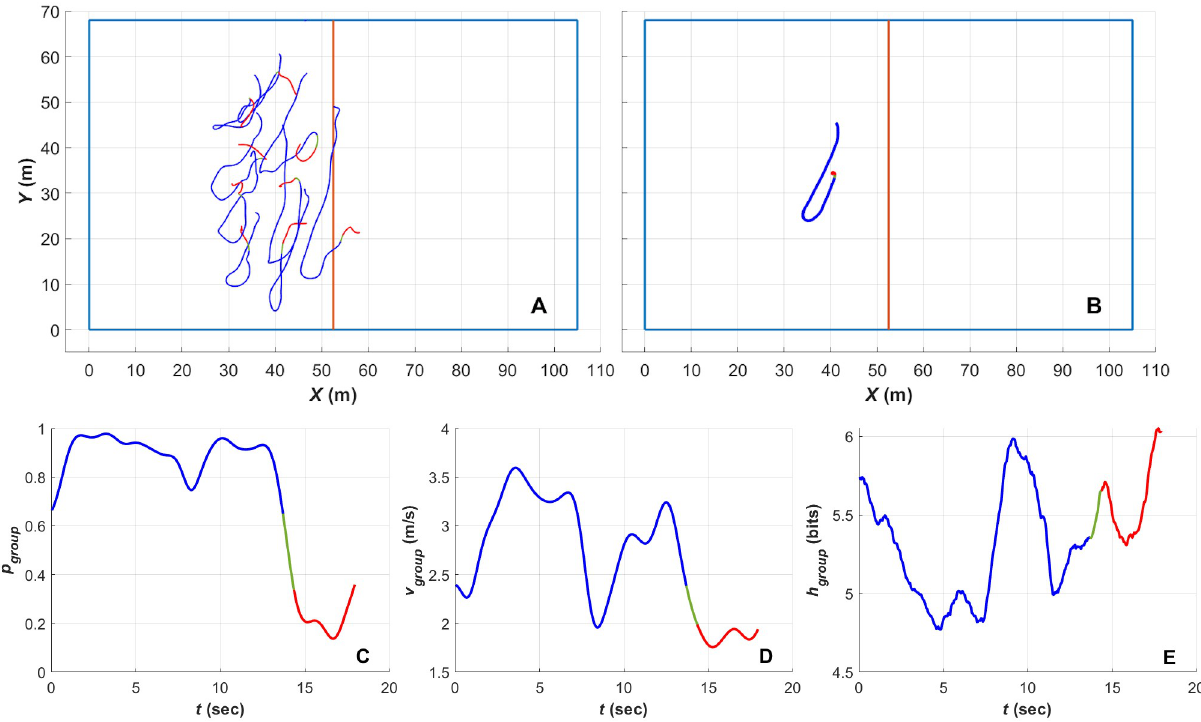
Fig 12. Player position traces and order parameter time series plots for an exemplar polar to swarm transition. The blue, green and red sections of the traces denote the segments of the transition spent in the polar, transitional and swarm states respectively in all plots. (A) The position traces for all players (excluding the goal keeper) across the transition period. (B) The position trace for the centroid (mean position) of the team. (C) The plot of polarisation ( p ) time series for the team across the transition period. (D) The plot of the mean group speed ( � u group plot of the of group entropy ( H group ) time